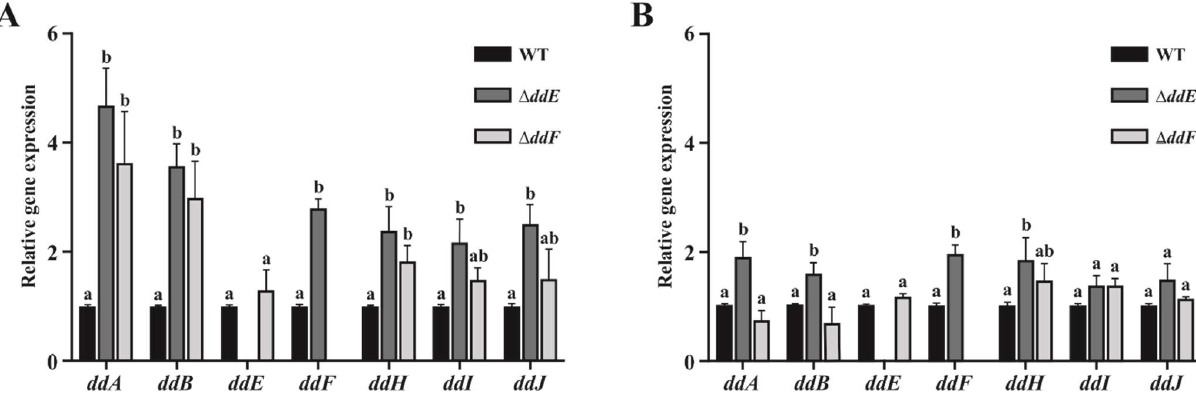
Figure 3. Relative expression values of ddABEFHIJ genes in Δ ddE and Δ ddF mutant strains compared to the WT strain at 5 h ( A ) and 24 h ( B ) of bacterial growth. The gyrase gene was used as an internal standard to normalize the values. Statistical significances are represented by letters a and b, which mean p < 0.05.